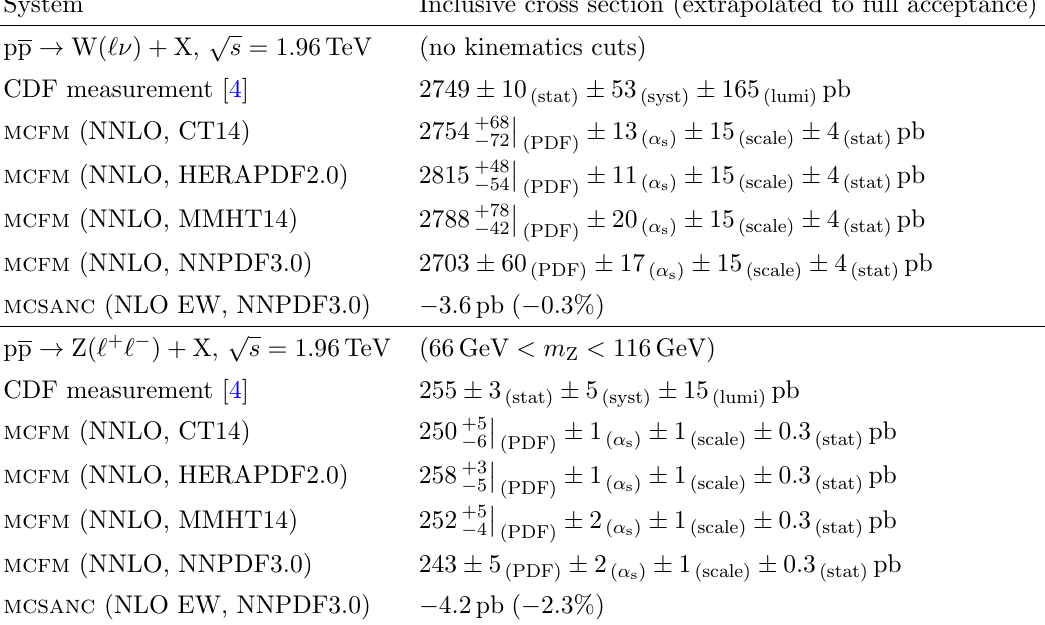
Table 10 . Comparison of the CDF and D0 inclusive cross sections for W (cid:6) and Z boson production p in pp collisions at s = 1 : 96 TeV to the NNLO pQCD results obtained with mcfm using the CT14, HERAPDF2.0, MMHT14, and NNPDF3.0 PDF sets, including NLO EW corrections computed with mcsanc (also listed independently in the last